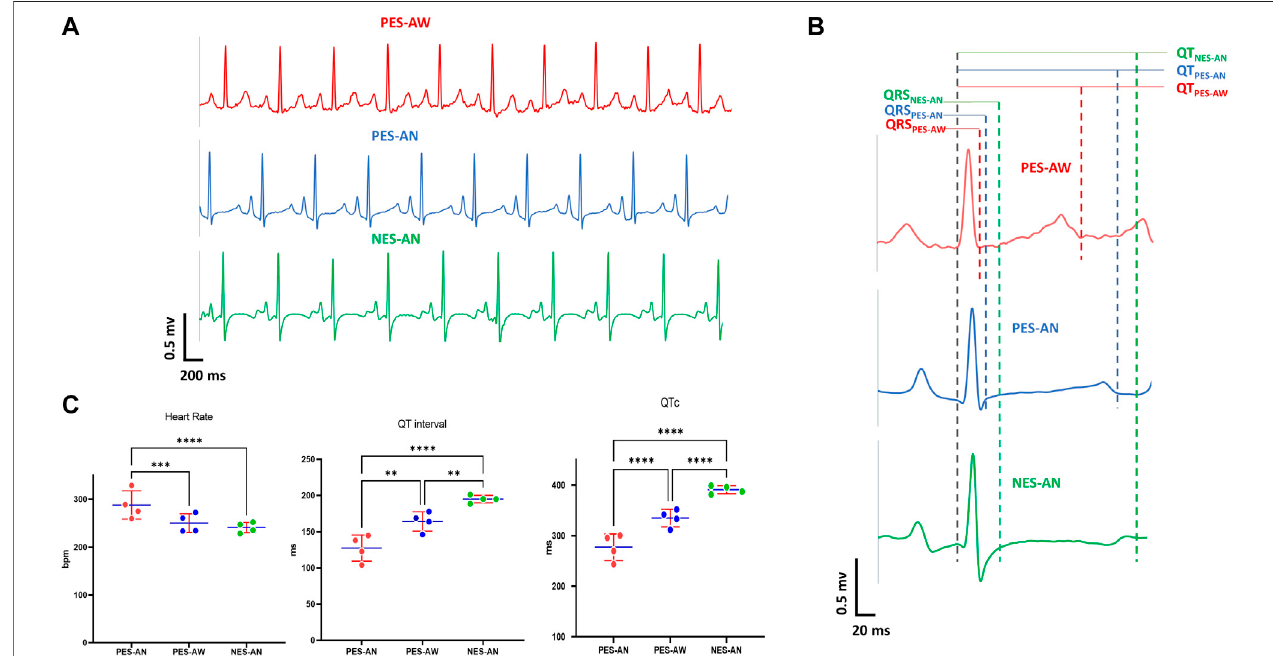
FIGURE2| EffectofrecordingmethodologyonECGparameters. (A) .ExampleleadIECGtracesofayoungguineapigacquiredbythreemethods:PES-AW,PES-AN,and NES-AN. (B) .ArepresentativeECGbeatofayoungfemaleguineapigfromPES-AW,PES-AN,andNES-AN. (C). ComparisonofthreeECGmetrics(heartrate,QTinterval,and QTc) from PES-AW, PES-AN, and NES-AN. 2-way ANOVA with 0.05 FDR cutoff was used to calculate the p values. pp p < 0.01, ppp p < 0.001, pppp p < 0.0001.